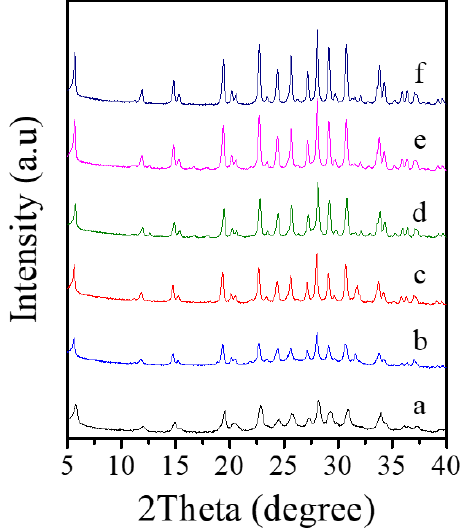
Figure 7. XRD patterns of Fe-LTL zeolite crystals synthesized at ( a ) 80 °C, ( b ) 100 °C, ( c ) 120 °C, ( d ) 140 °C, ( e ) 160 °C, ( f ) 180 °C, respectively. After the systematic synthesis, aluminosilicate gel for crystallization of Fe-LTL zeolites at 80 with molar ratio of 2.1Na 2 O / 3.4K 2 O / Al 2 O 3 / 15SiO 2 / 0.6FeCl 3 / 250H 2 O is